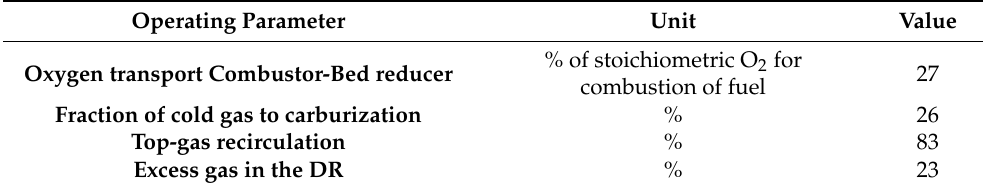
Table 7. Operating parameters of the DFB-DR routeThese are the parameters that are not fixed based on assumptions but determined so that the mass and energy balances are respected. Operating Parameter Unit Value % of stoichiometric O 2 for Oxygen transport Combustor-Bed reducer 27 combustion of fuel Fraction of cold gas to carburization % 26 Top-gas recirculation % 83 Excess gas in the DR